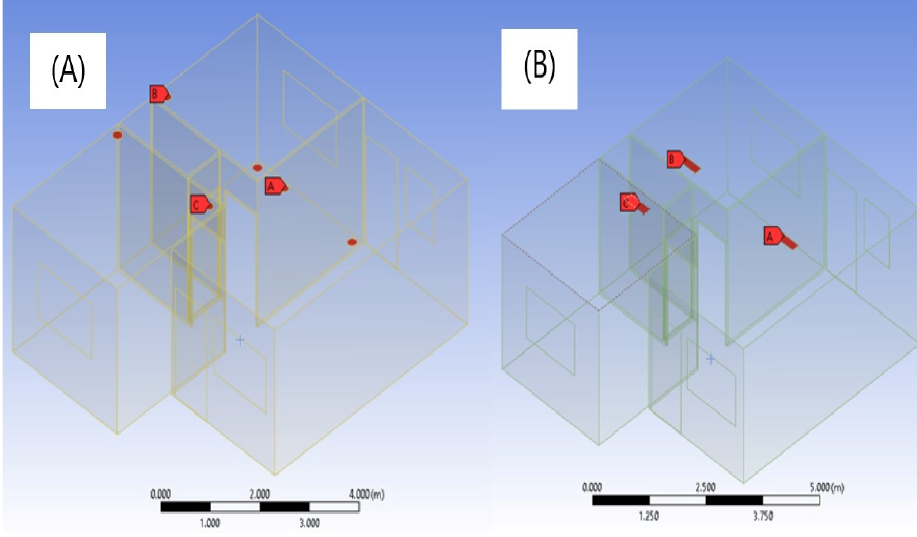
Figure 7. Con fi guration of a circular channel ( A ) and a rectangular air outlet ( B ). Figure 7. Configuration of a circular channel ( A ) and a rectangular air outlet ( B ).